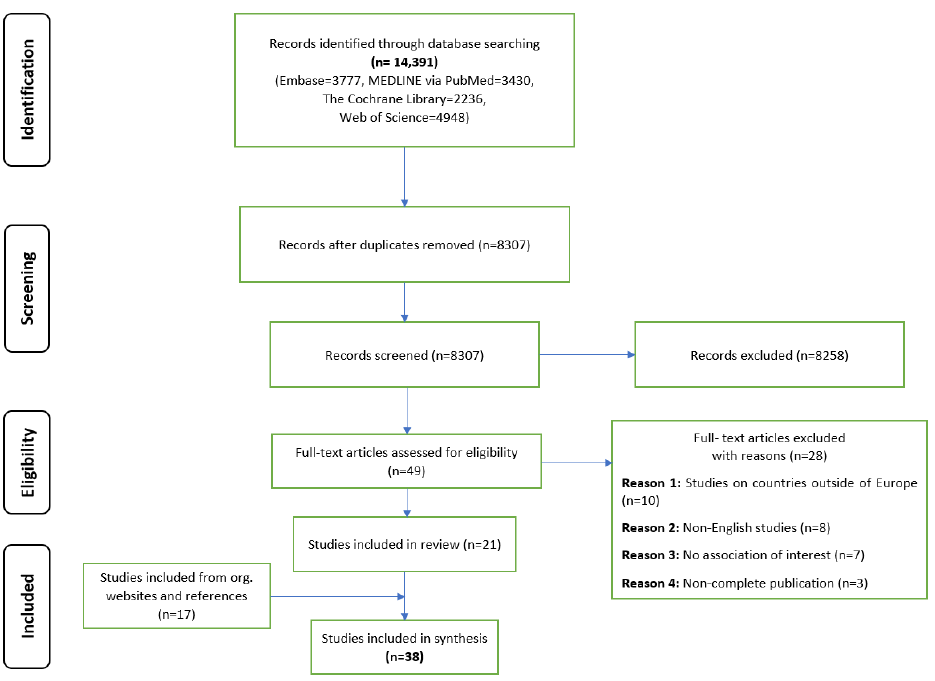
Figure 1. PRISMA Flow Diagram.